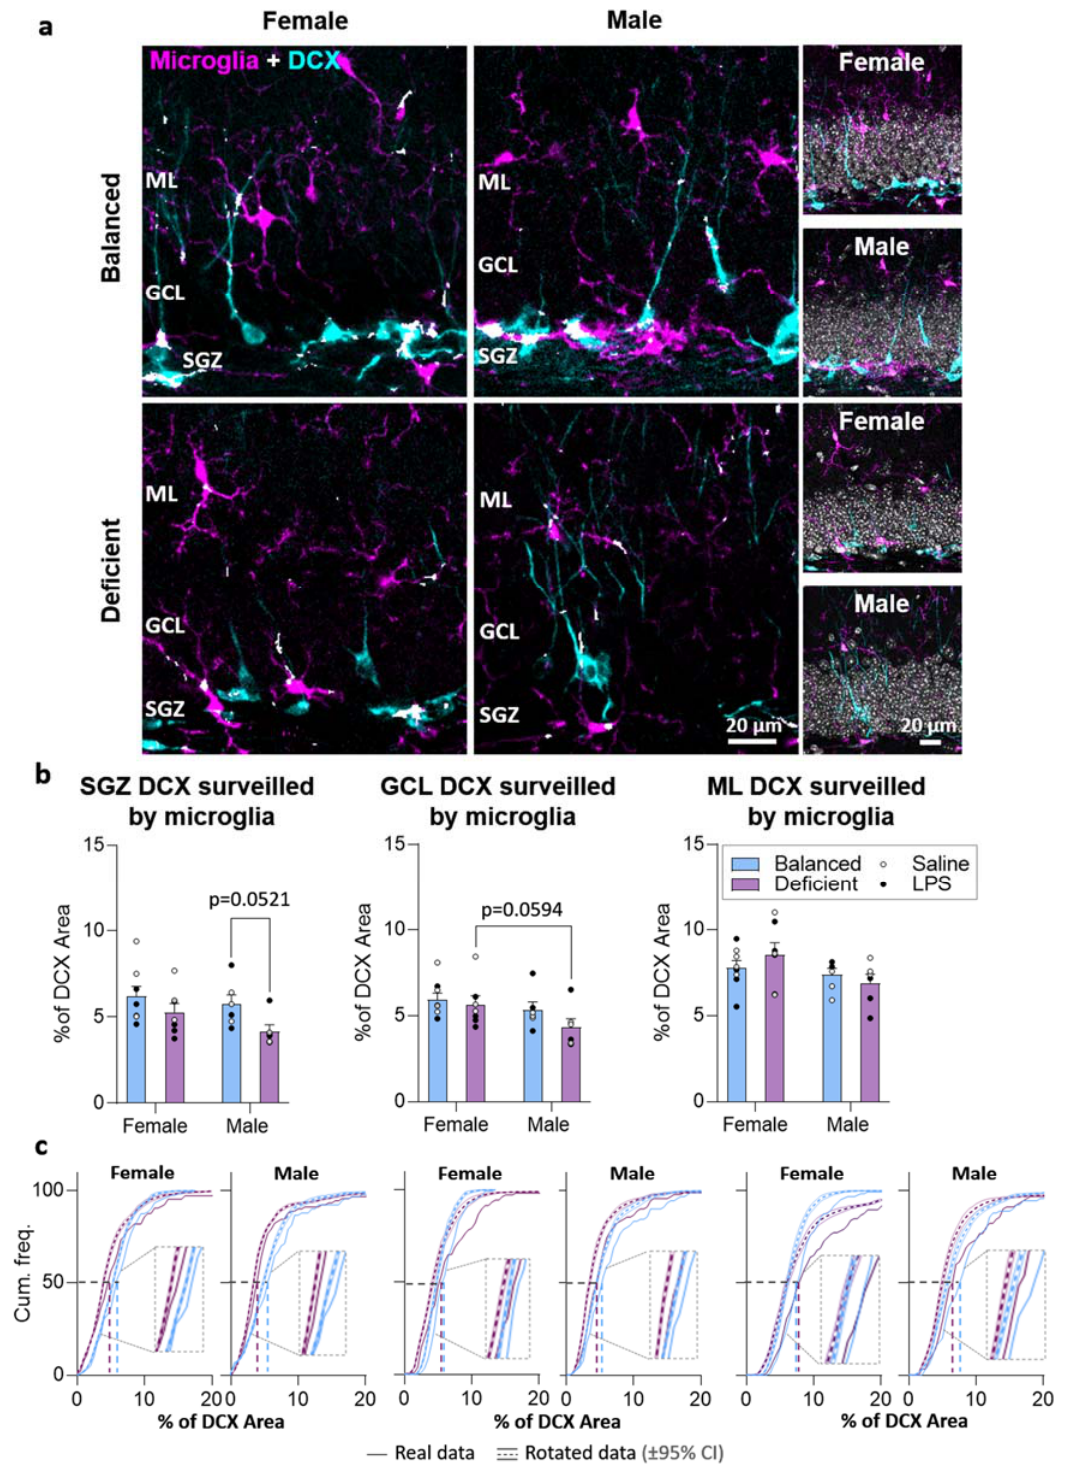
Figure 7. Reduced spatial proximity between microglia and neuroblasts in mice fed with the n ‐ 3 PUFA ‐ deficient diet. ( a ) Confocal images (maximum intensity projections, z = 13.8 μ m) of the dentate gyrus of the hippocampus showing neuroblasts expressing doublecortin (DCX, cyan), microglia expressing the green fluorescence protein (GFP, magenta), and the spatial colocalization of both stainings (white) in the subgranular zone (SGZ), granule cell layer (GCL), and molecular layer (ML) of female and male mice fed with the balanced or n ‐ 3 PUFA ‐ deficient diets. Insets on the right also show DAPI staining in gray. Images from each animal group are available in Supplementary Figure S4. ( b ) The proportion of area of neuroblasts (DCX expressing cells) surveilled by microglia